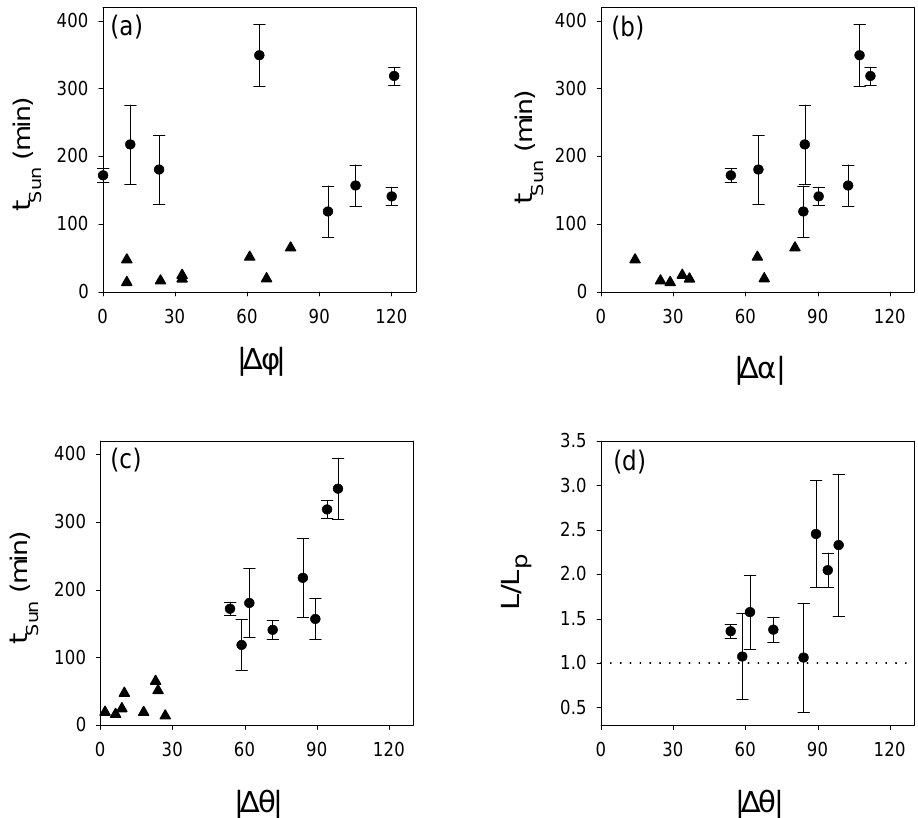
Fig. 6. Release time t Sun versus angular separations between the spacecraft footpoint and the flare locations. Circles are Ulysses data points and triangles are Wind data points. (a) t Sun versus difference in longitudes | 1φ | = | φ footpt − φ flare | ; (b) versus great circle angular separation | 1α | between footpoint and flare; (c) versus difference in latitude | 1θ | = | θ | 1θ | . Plots are given for only 8 SEP events because the flare location was not known for 1 event.